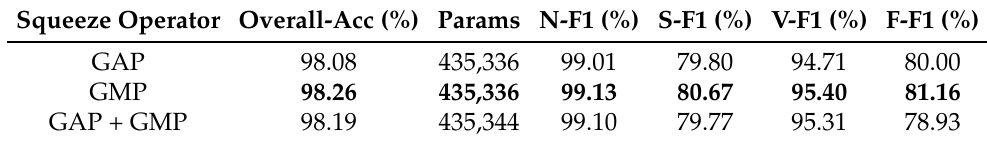
Table 3. Effect of different squeeze operators in the